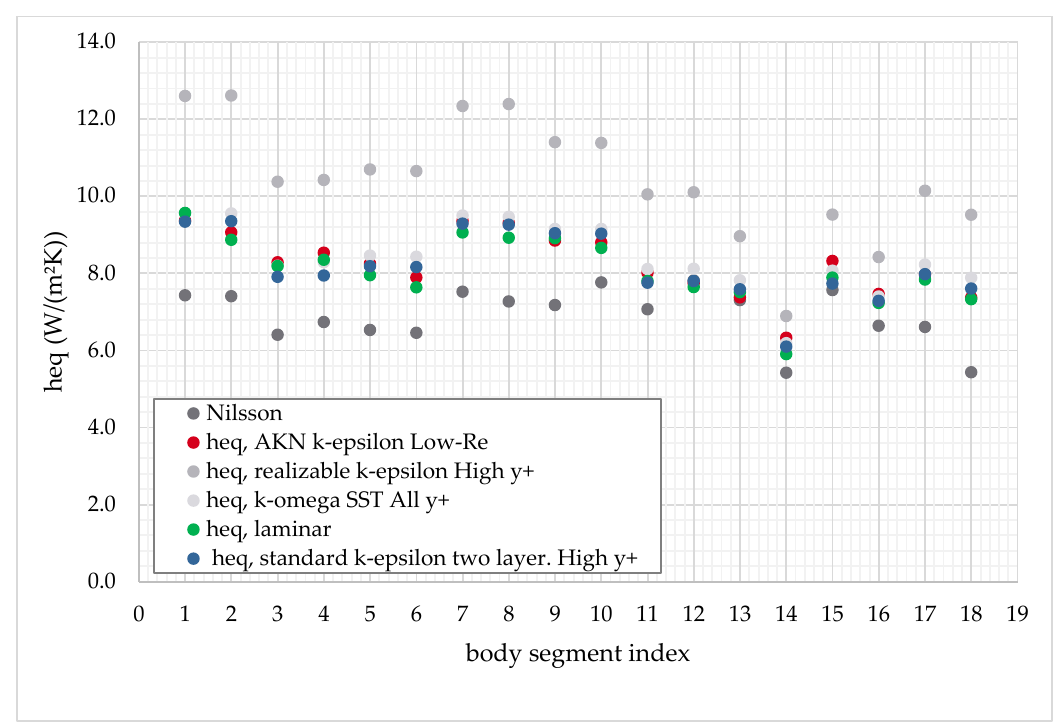
Figure 4. Comparison of the turbulence models regarding the heat transfer coefficients. The heat transfer coefficients are averaged over the corresponding body part surface. Figure 5 shows the different heat transfers across the individual body parts for different equivalent temperatures.